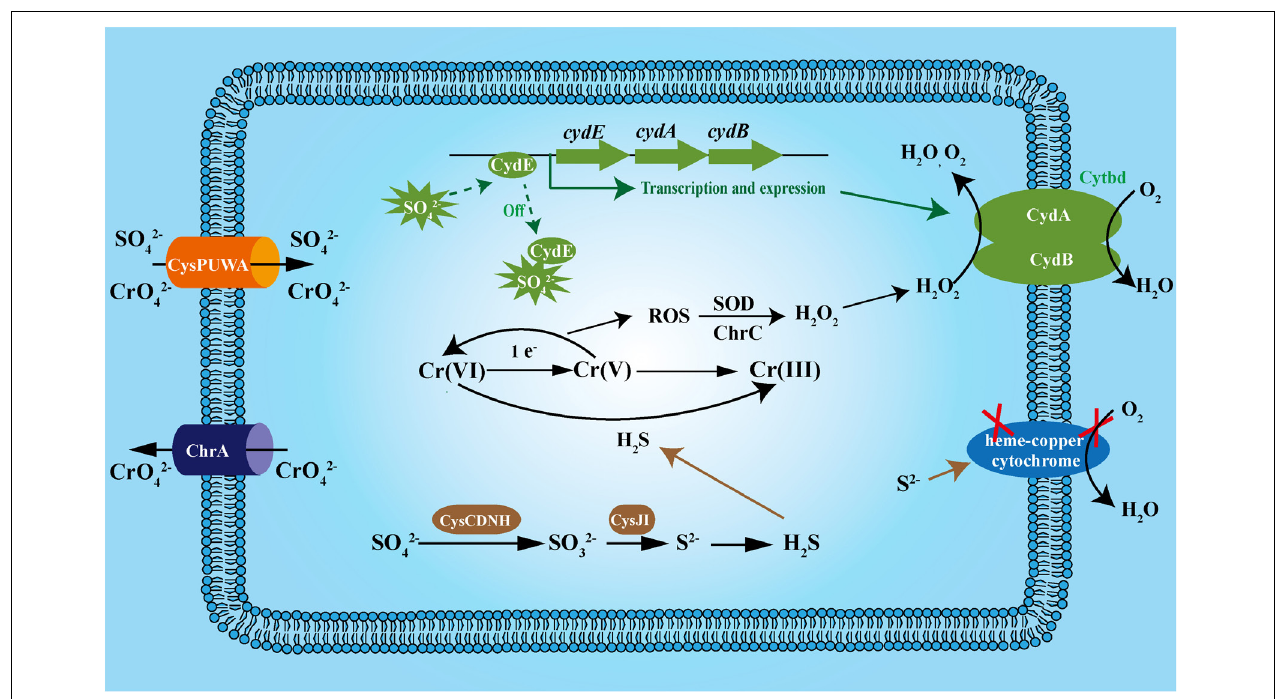
FIGURE 7 | The proposed mechanism by which Cytbd contributes to sulfide and chromate resistance in Alishewanella sp. WH16-1. CydE, GbsR family regulator; CydA, Cytochrome bd complex subunit A; CydB, Cytochrome bd complex subunit B; ChrA, chromate efflux protein; CysPUWA, sulfate/chromate transporter; CysND, sulfate adenylyltransferases; CysC, adenylylsulphate kinase; CysH phosphoadenylylsulphate reductase; CysIJ, sulfite